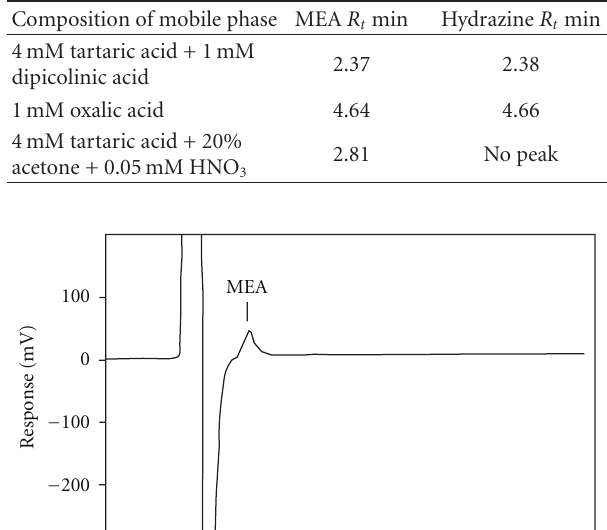
Table 1: Retention time ( R t ) studies of MEA and hydrazine in di ff erent mobile phase.